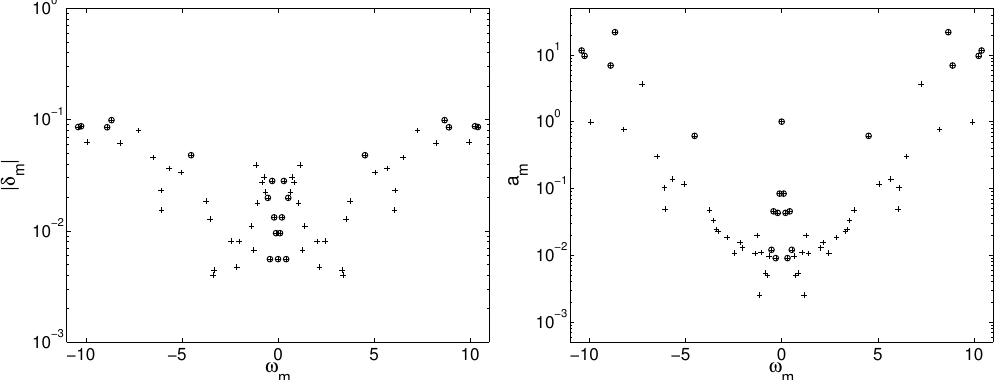
Figure 5. One-blade turbine case: growth rates ( left ) and amplitudes ( right ) vs. frequencies of the DMD modes. Circles represent the modes selected by HODMDc for constructing the HODMD-based Reduced Order Model (ROM) and crosses represent the transient modes, omitted in the DMD expansion (1). Table 3. Frequencies selected by HODMDc (in rad/s) presented in Figure